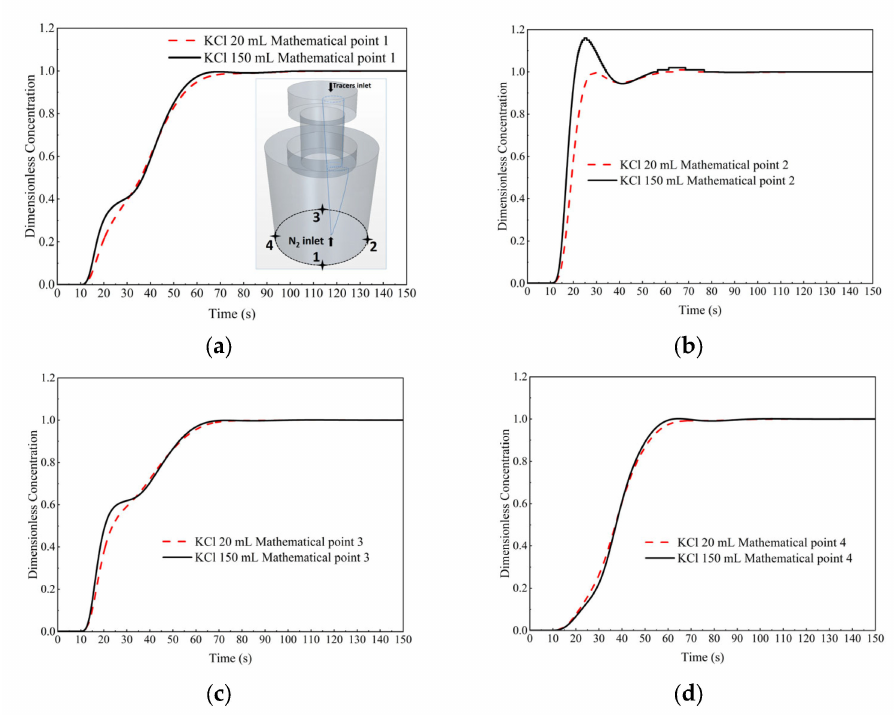
Figure 14. Comparison of the dimensionless concentration-time curves between the case of 20 mL KCl tracer and the case of 150 mL KCl tracer at different monitor locations. ( a ) Monitor point 1, ( b ) Monitor point 2, ( c ) Monitor point 3, and ( d ) Monitor point